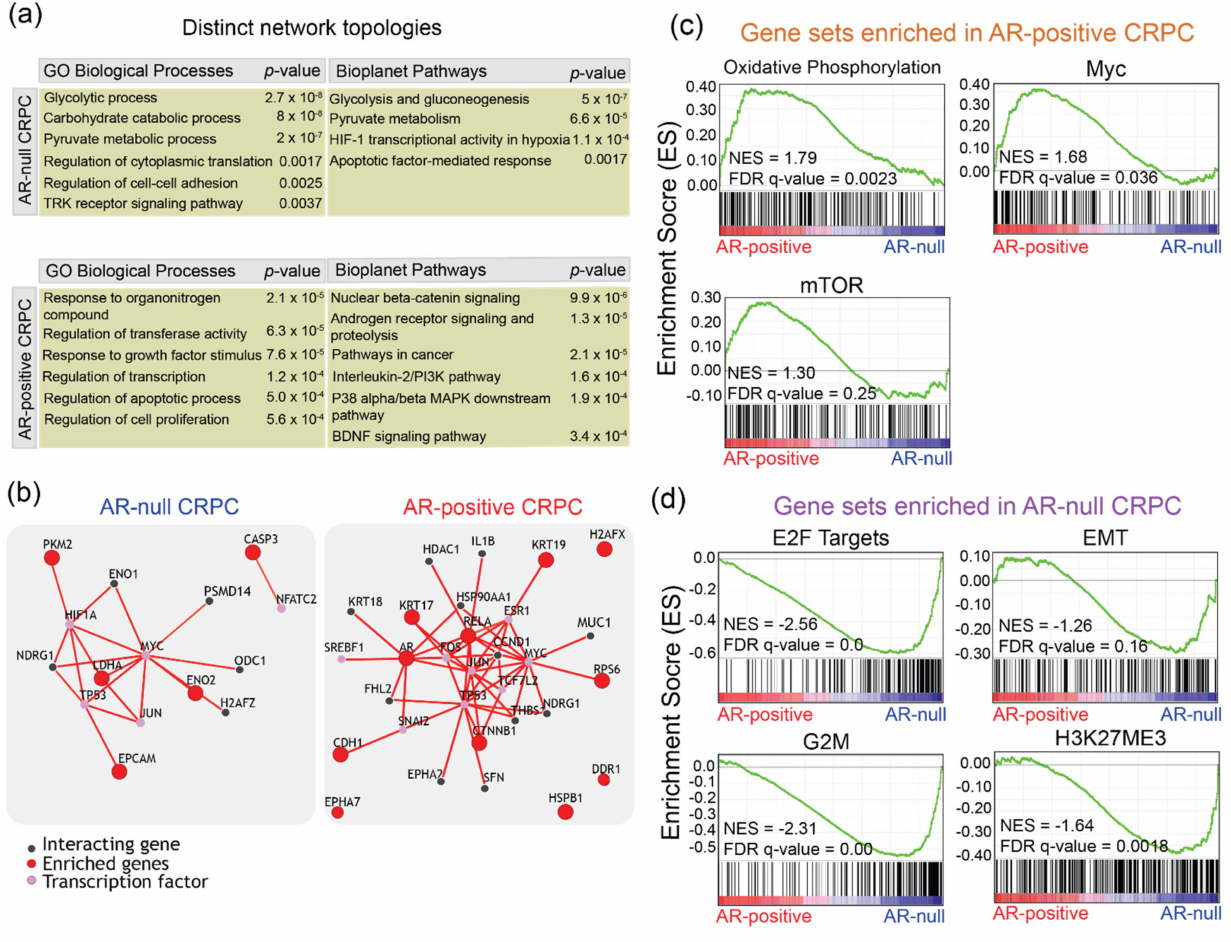
Figure 3. AR-null and AR-positive LuCaP PDX tumors display distinct signaling network topologies. ( a ) Representative tables of enriched pathways and ontologies highlighted by Enrichr analysis with an input of enriched genes that increased by at least 1.5-fold comparatively between AR-positive and AR-null CRPC, using the RPPA proteomic data. ( b ) PathwayNet predicted interactions between the enriched genes and other genes, and transcription factors are shown in network diagrams for AR-null and AR-positive CRPC. ( c ) GSEA enrichment plots showing upregulation of oxidative phosphorylation, c-Myc, and mTOR in AR-positive LuCaP PDX tumors. ( d ) GSEA enrichment plots showing upregulation of E2F targets, EMT, G2M, and H3K27ME3 in AR-null LuCaP PDX